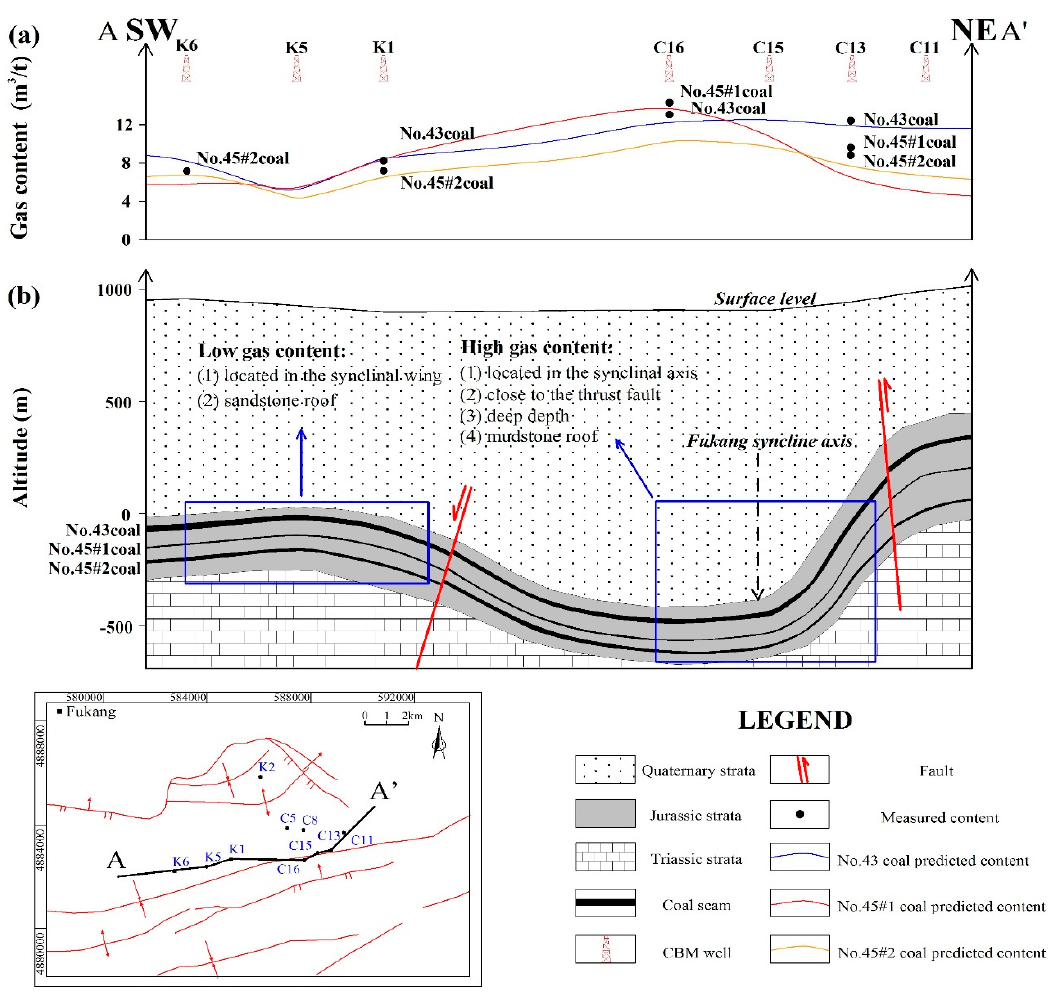
Figure 16. The change of gas content in the SW–NE profile line: ( a ) the change of gas content in the Nos. 43, 45-1, and 45-2 coal seams; ( b ) SW–NE structural cross section for low and high gas content.